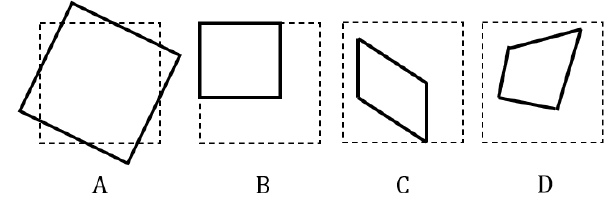
Figure 2. Distortion types that can be corrected by our proposed network. ( A ): rotation. ( B ): Scaling. ( C ): Affine. ( D ): Projective. These are planar transformations identified by Hartley and Zisserman [13]. One or more distortion types may be present in a distorted